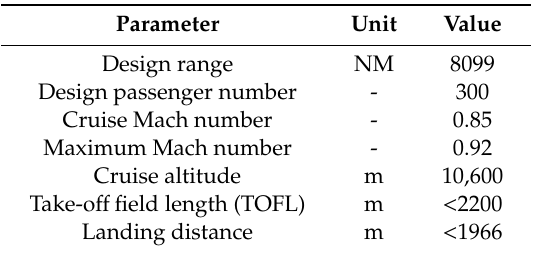
Table 1. Top-level aircraft requirements of reference long-range aircraft Sustainable and Energy E ffi cient Aviation-LR (SE 2